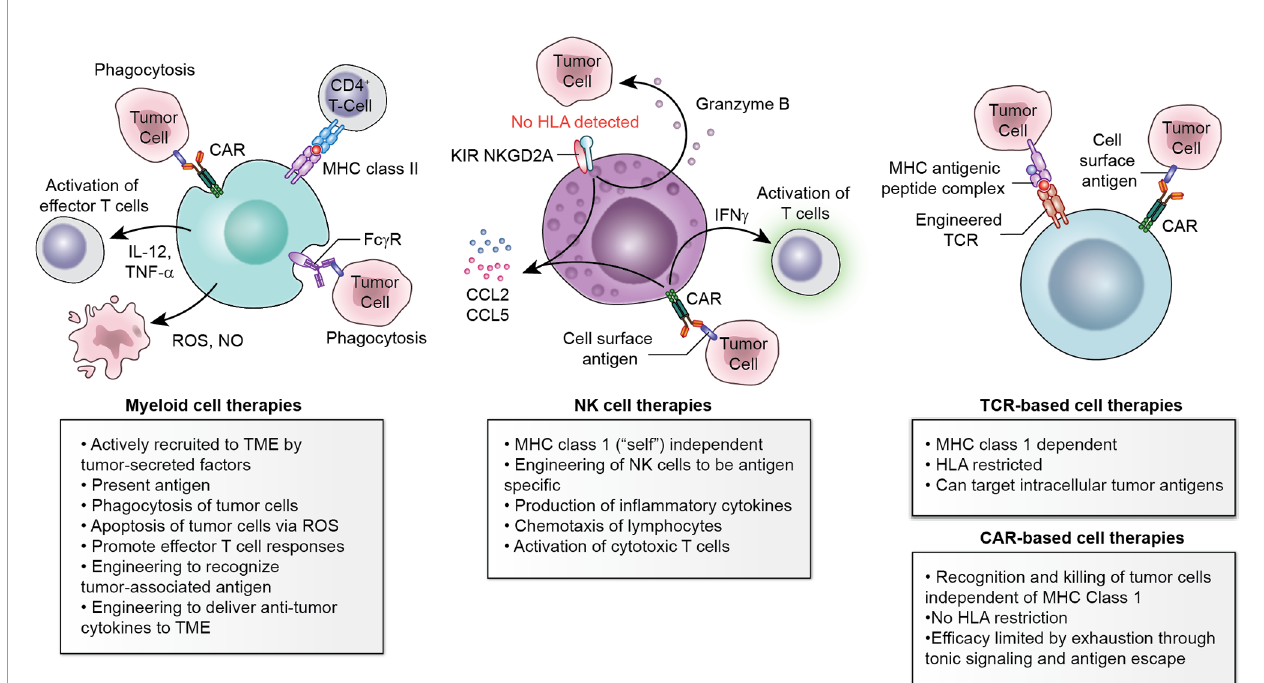
FIGURE 1 | Multiple cell types available to engineer for adoptive cellular therapy. Myeloid cells, NK cells, and T-cell-based therapies each have advantages and disadvantages which should be considered within the context of the histology to be